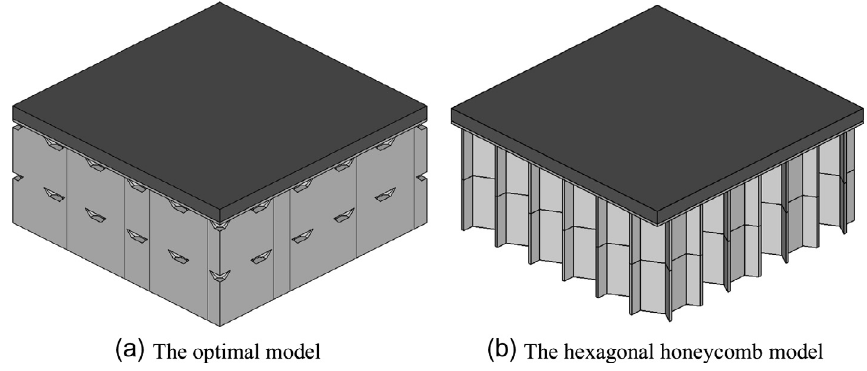
Figure 12. The optimal model and the hexagonal honeycomb model to be analyzed.